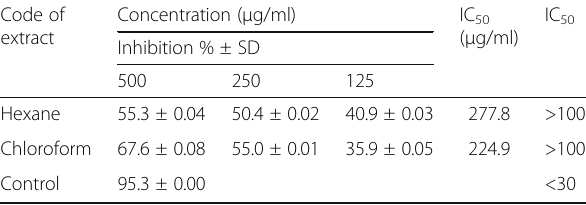
Table 6 The cytotoxic effect (expressed as % inhibition and IC50 values) of hexane and chloroform fractions of S. latifolius tested at 125, 250 and 500 μ g/ml against Vero cells Code of Concentration ( μ g/ml) extract